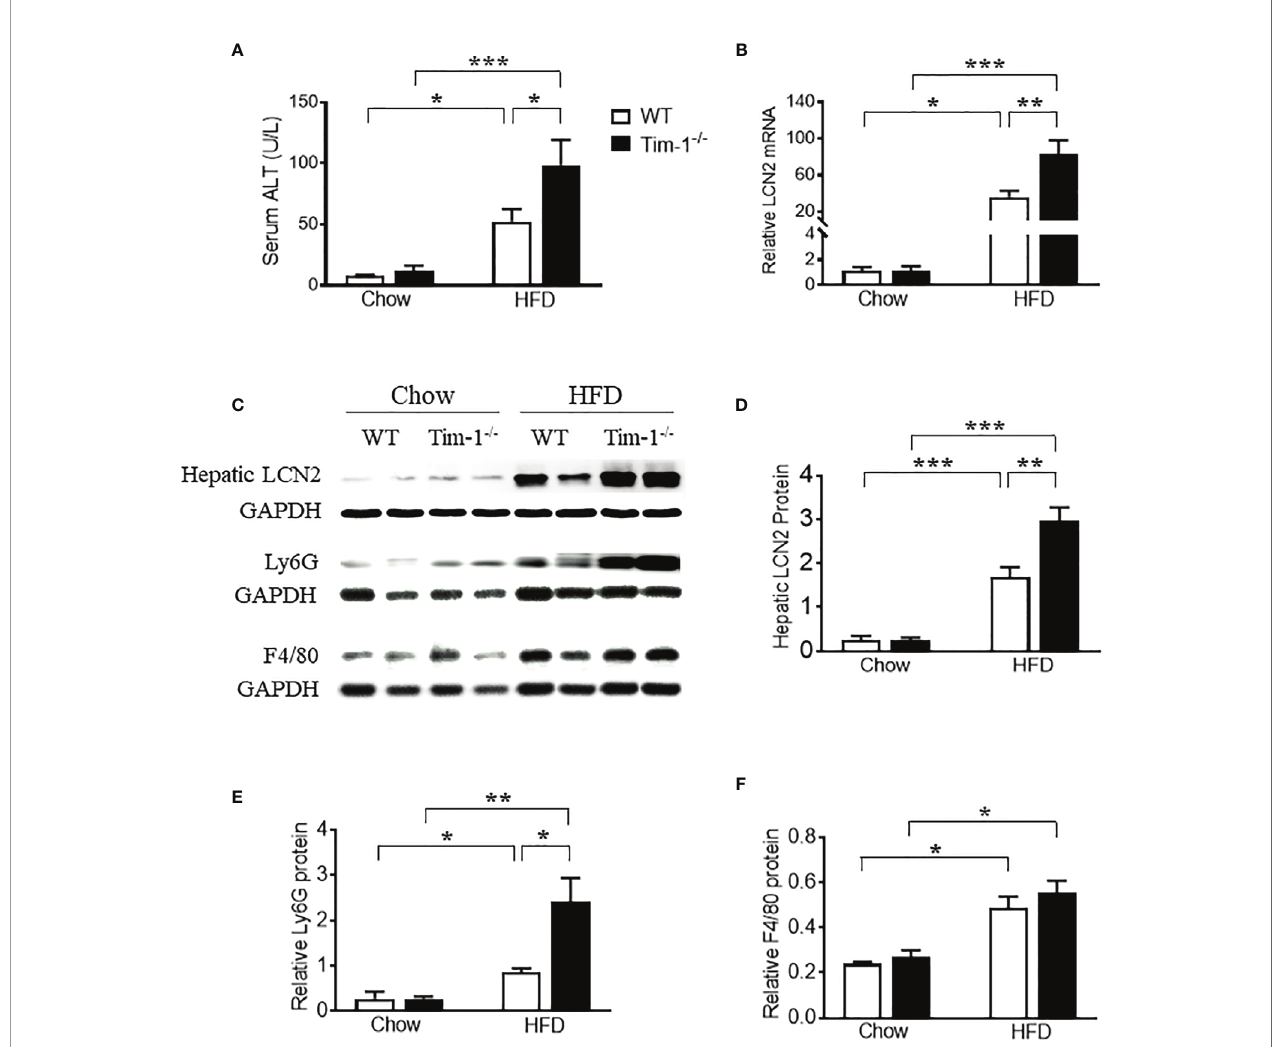
FIGURE 5 | Tim-1 de fi ciency enhanced HFD-induced liver injury. (A) Serum alanine aminotransferase (ALT) concentration in chow or HFD-treated WT and Tim-1 -/- mice. (B) Real-time qPCR analysis of lipocalin 2 (LCN2) transcript in chow or HFD-fed WT and Tim-1 -/- mouse livers. (C – F) Representative Western blot image and quantitative analysis of hepatic LCN2, Ly6G/C, and F4/80 proteins. Values are mean ± SEM. n=4-6 mice. Statistical differences were assessed by one-way ANOVA with Tukey ’ s multiple comparisons test; * P <0.05, ** P <0.01, *** P